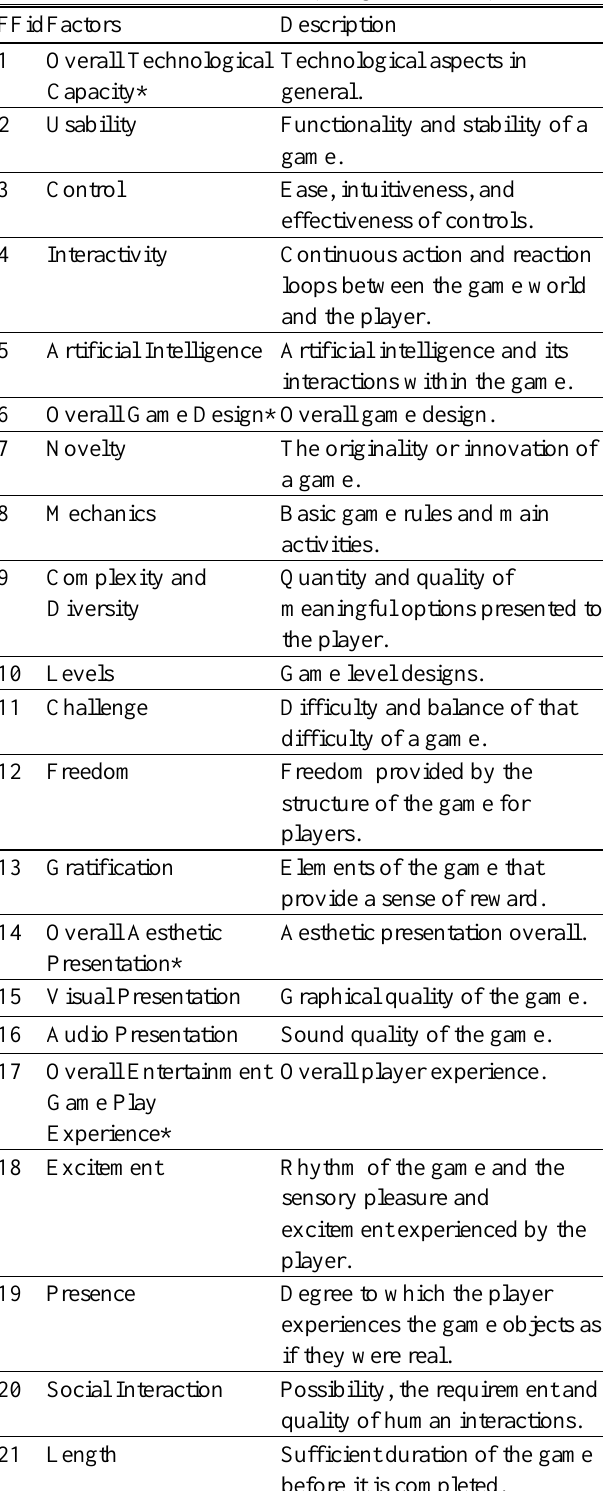
Table 1. Fun Factors (Shen, Wang and Ritterfeld,